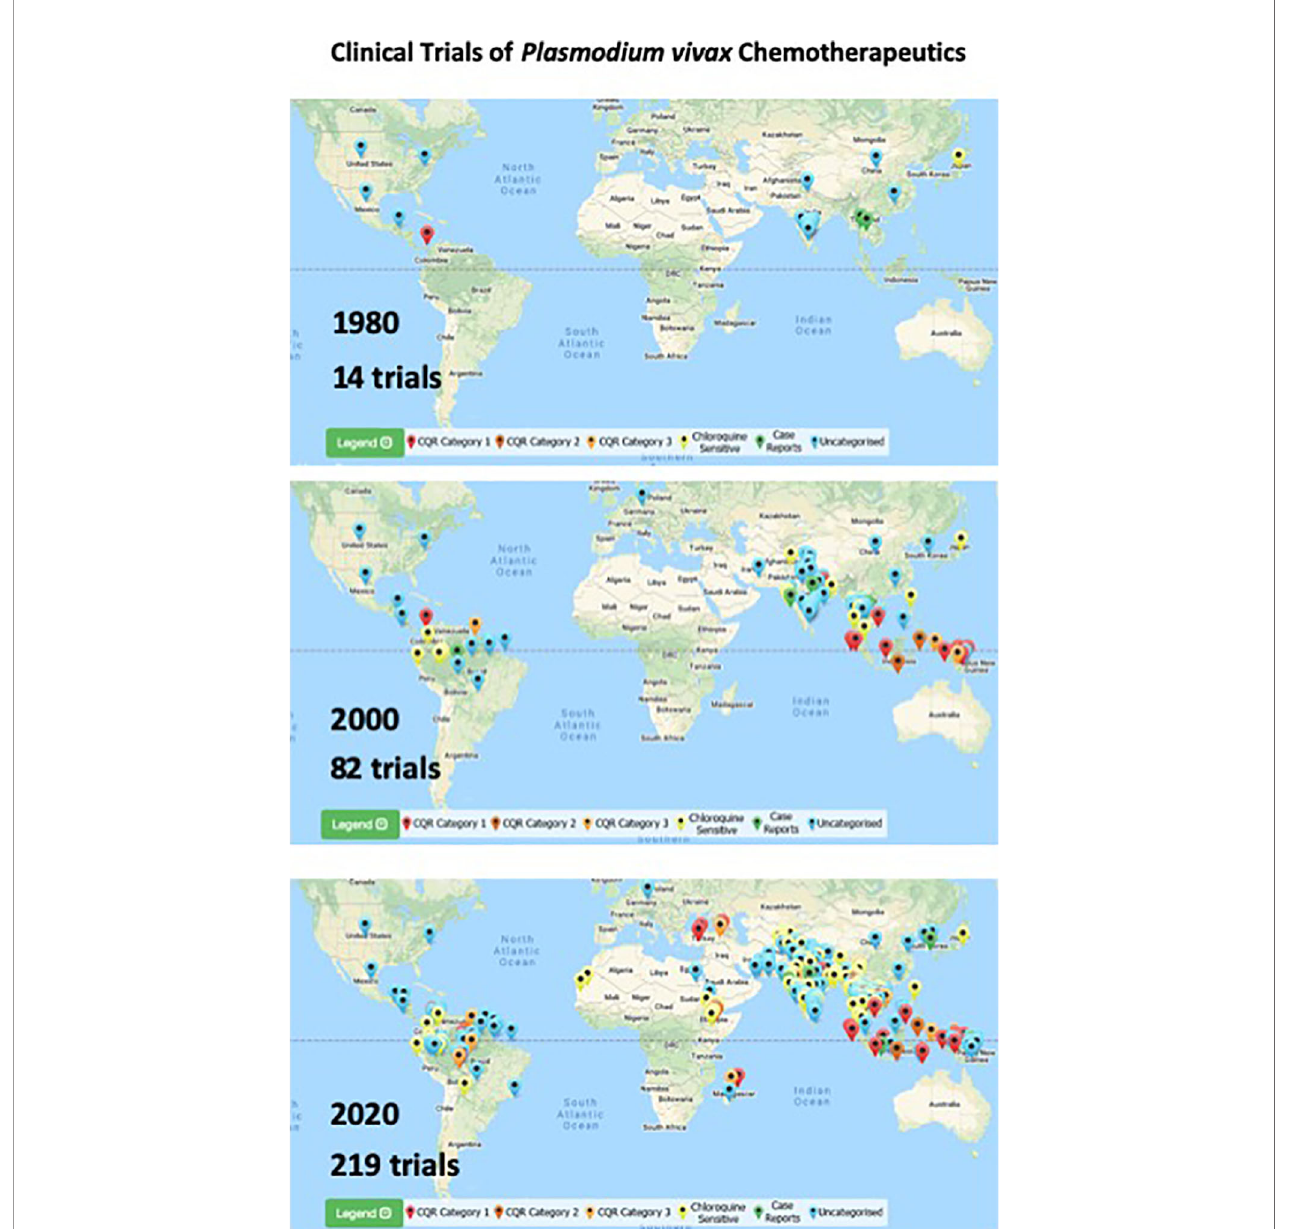
FIGURE 5 | Maps illustrating location and cumulative numbers of clinical trials of chemotherapeutics involving P. vivax infected-patients up to 1980, 2000, and 2020 (top to bottom). Pin colors correspond to categories of responses to chloroquine therapy as indicated in the key at bottom of each map. Images and numbers taken from Vivax Surveyor on 8 April 2021